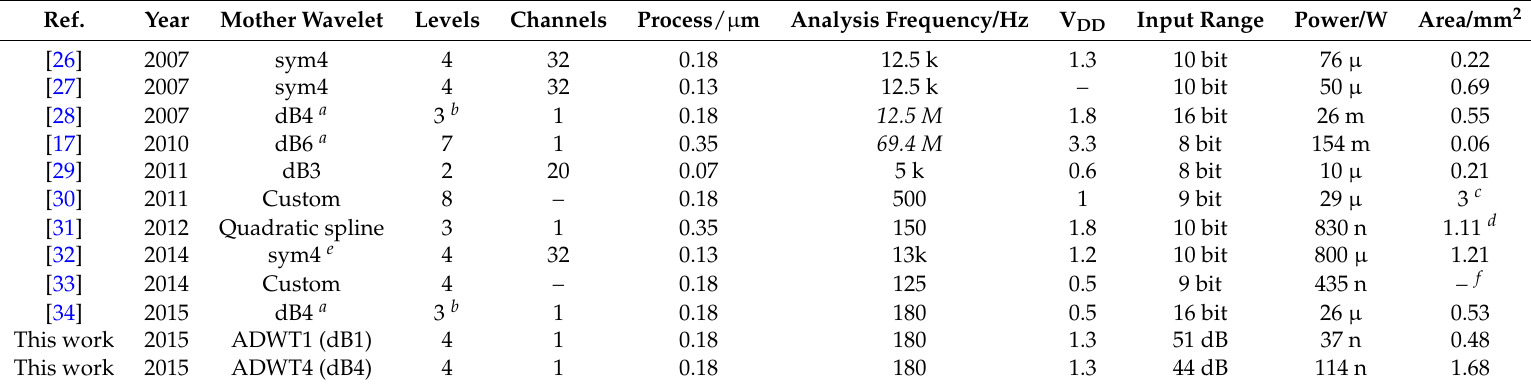
Table 6. Comparison of the ADWT with previously reported digital DWT circuits. Values in italics are either unclear or have been extrapolated from values given in the source